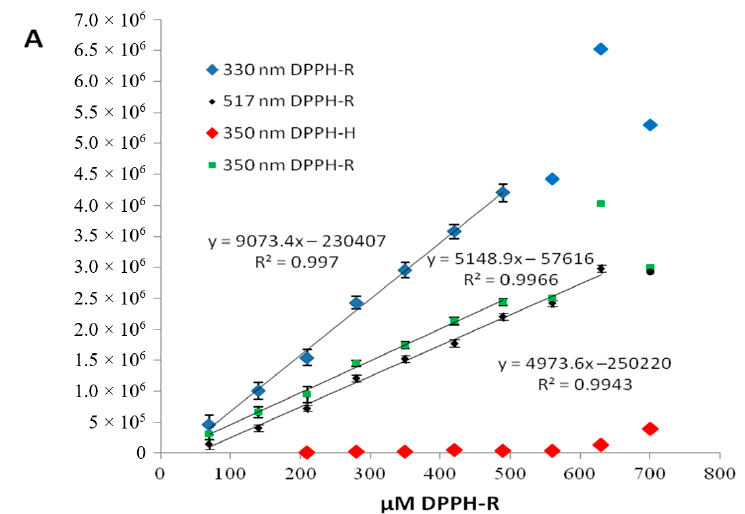
Figure 3. Dependence of the peak area of the DPPH radical on its concentration measured at different wavelength. Chromatographic conditions: column—a Zorbax Eclipse XDB-C18 (4.6 × 150 mm, 5 µm), mobile phase—methanol/water (80:30, v / v ), flow rate—1 mL/min. The presence of the trace content of DPPH-H (2,2-diphenyl-1-picrylhydrazine) at each measured sample is illustrated in red.